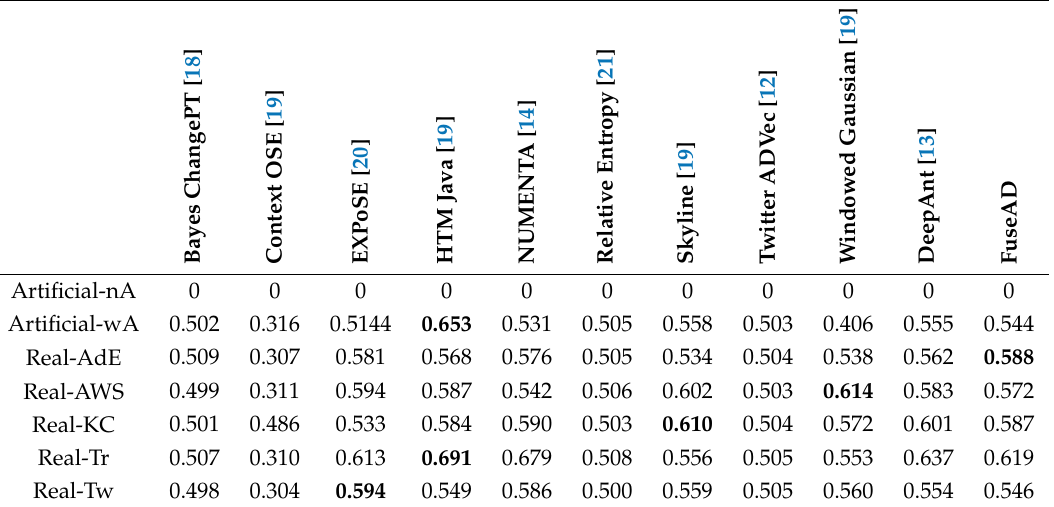
Table 2. Comparative evaluation of anomaly detection methods on the NAB dataset. Average AUC per domain is reported here. Bold numbers show highest AUC in a particular